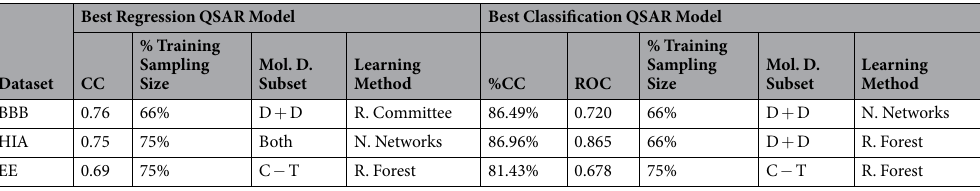
Table 1. Metrics of the best QSAR models for each